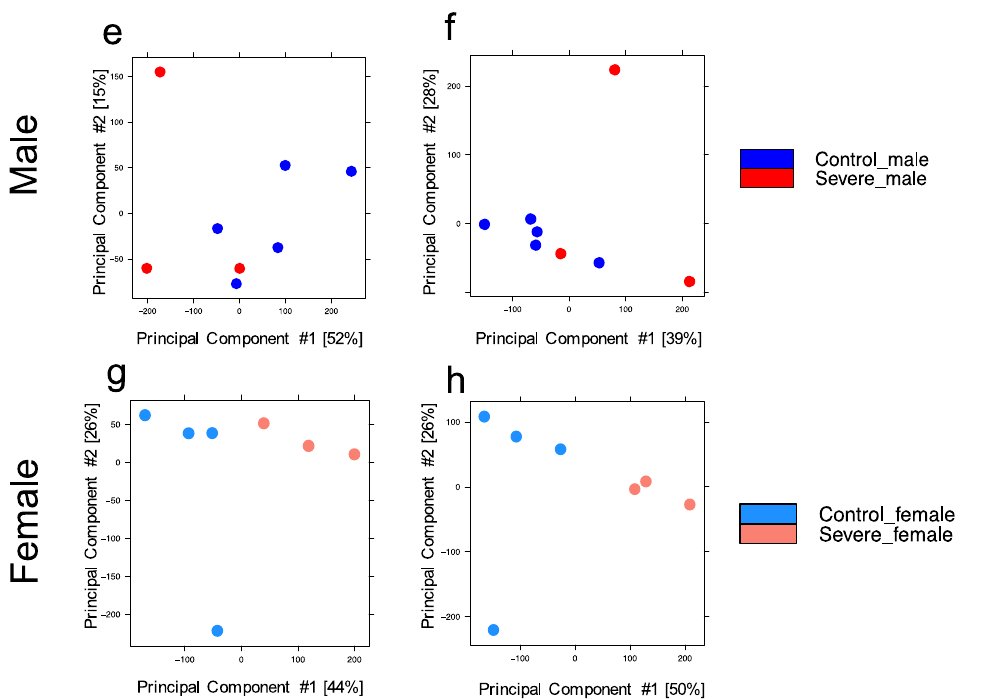
Figure 1. Principal component analysis of genome-wide histone modification signal. Genome-wide normalized histone modification signals were split into consecutive, non-overlapping bins (10 kb). PCA was calculated on the resulting matrix and samples colored by group (control males in blue, control females in light blue, severe AD males in red, severe AD females in pink). ( a , b ) Signal across all chromosomes for H3K4me3 and H3K27me3, respectively. ( c , d ) Signal across all autosomes for H3K4me3 and H3K27me3, respectively. Signal across all chromosomes in males ( e , f ) and females ( g , h ) for both histone modifications